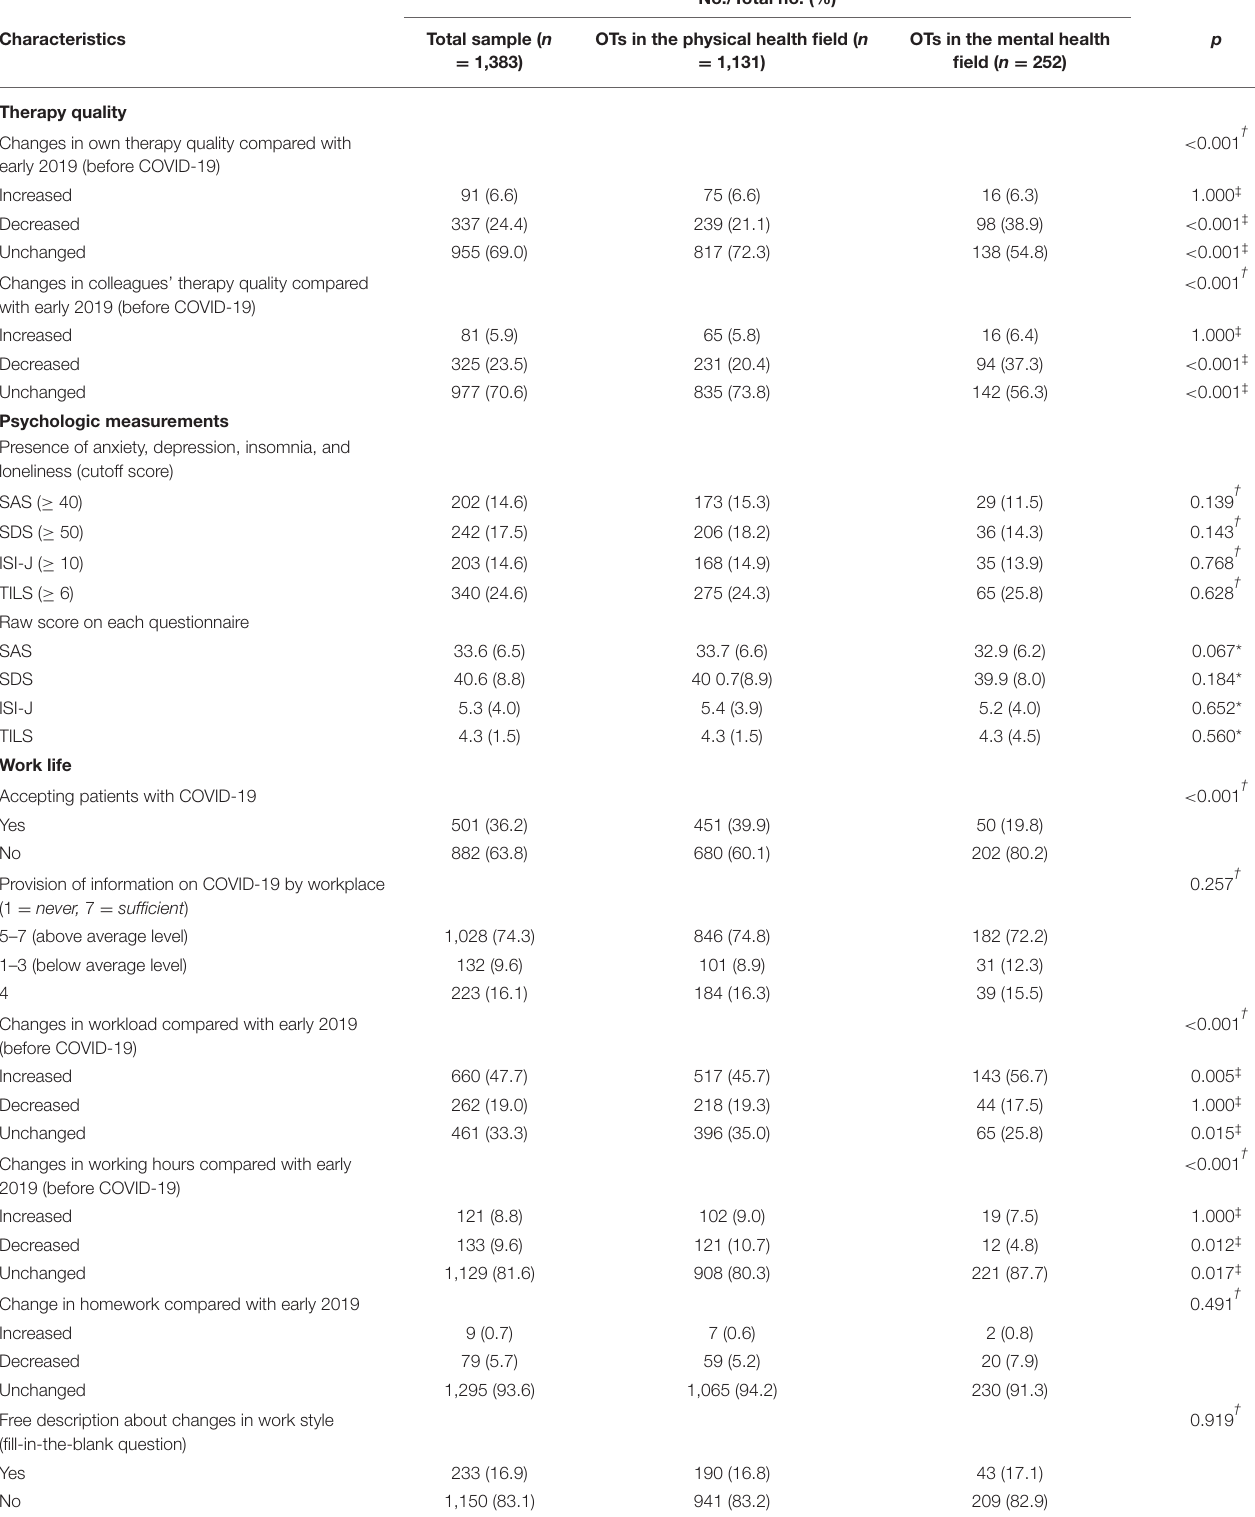
TABLE 2 | Questionnaire results of therapy quality, psychological measurements, and work